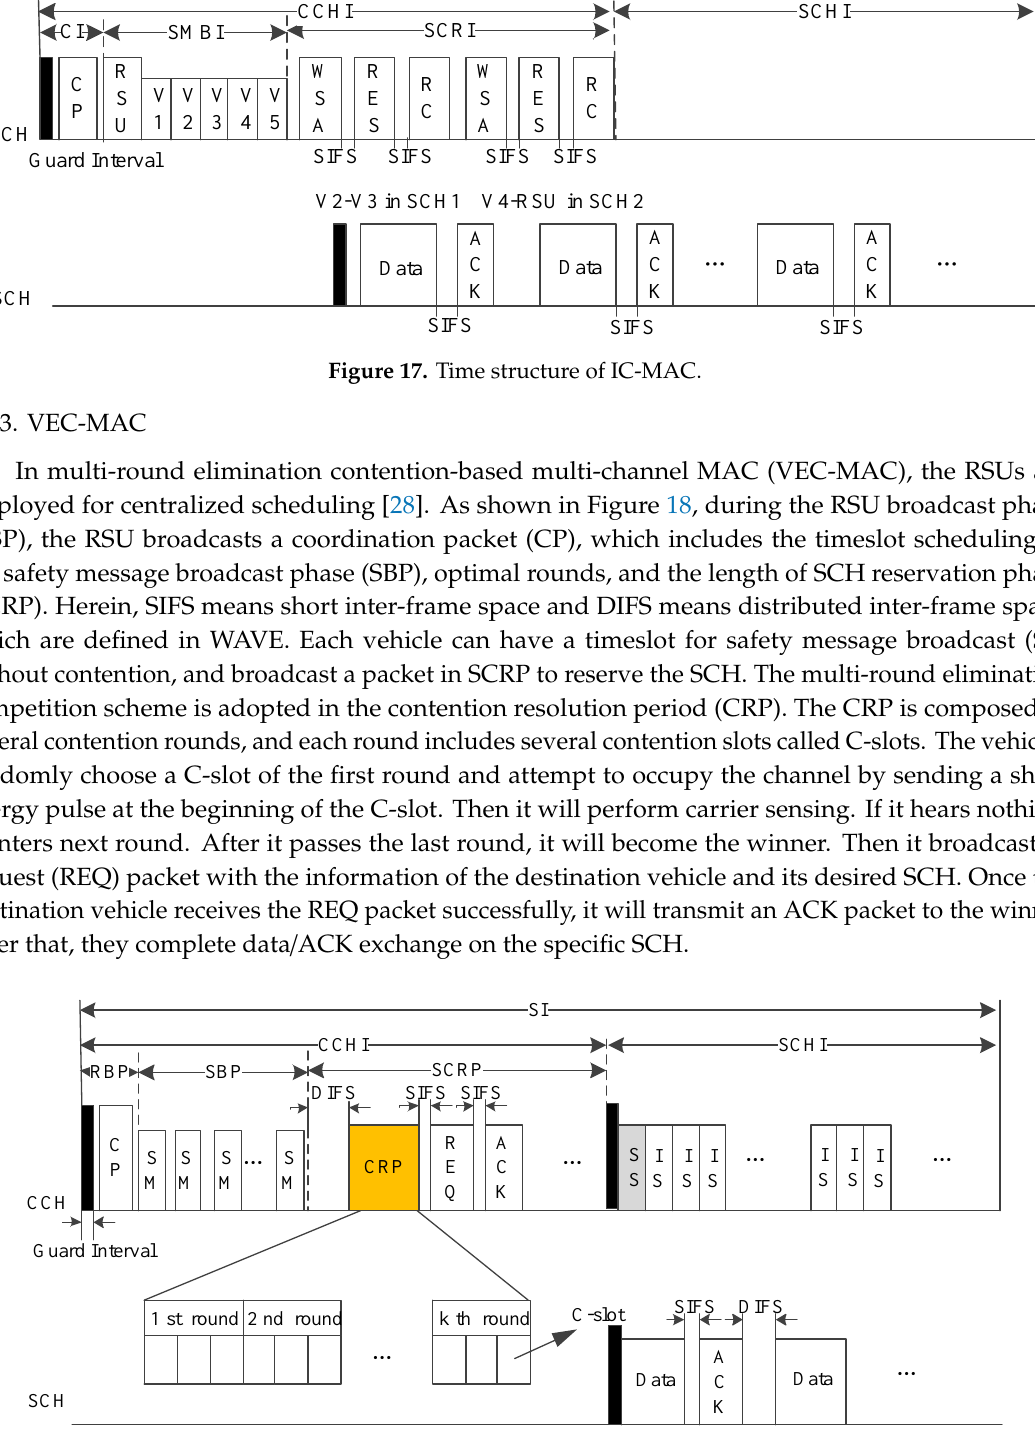
Figure 18. Time structure of VEC-MAC.